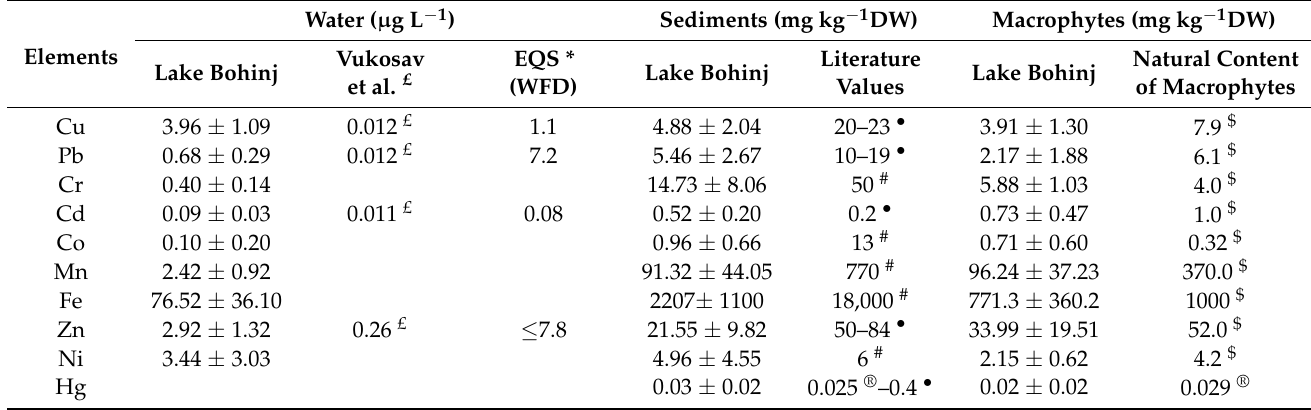
Table 2. Average concentrations ± SD of elements in water, bottom sediments and macrophytes in five plots in Lake Bohinj and literature values representing quality standards and natural contents.